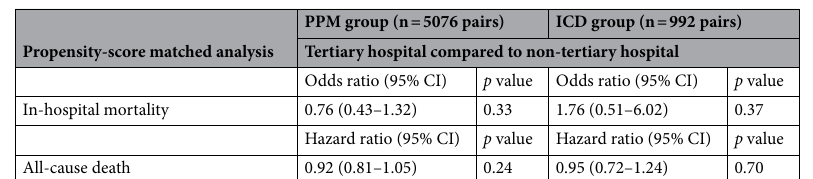
Table 3. Propensity score matched in-hospital mortality and all-cause death of patients undergoing new implantation of cardiac implantable electronic device in tertiary and non-tertiary hospital. CI, confidence interval; ICD, implantable cardioverter-defibrillator; PPM, permanent pacemaker.